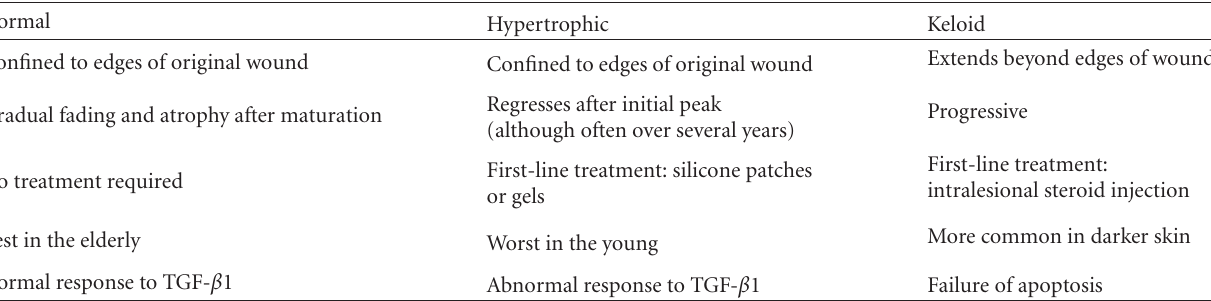
Table 1: Normal, hypertrophic, and keloid scars